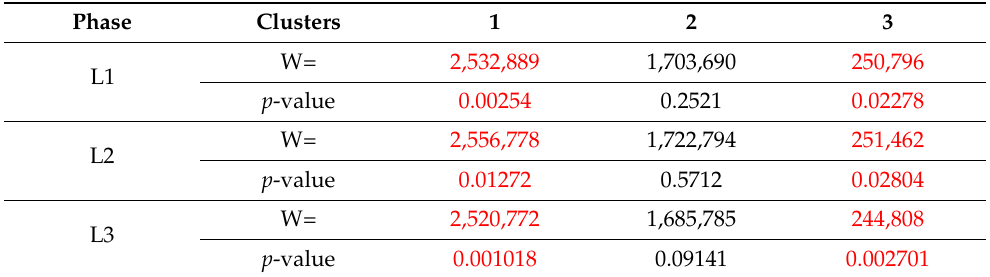
Table 13. Wilcoxon rank-sum test of the power-line flicker ( α = 0.05) in each phase.